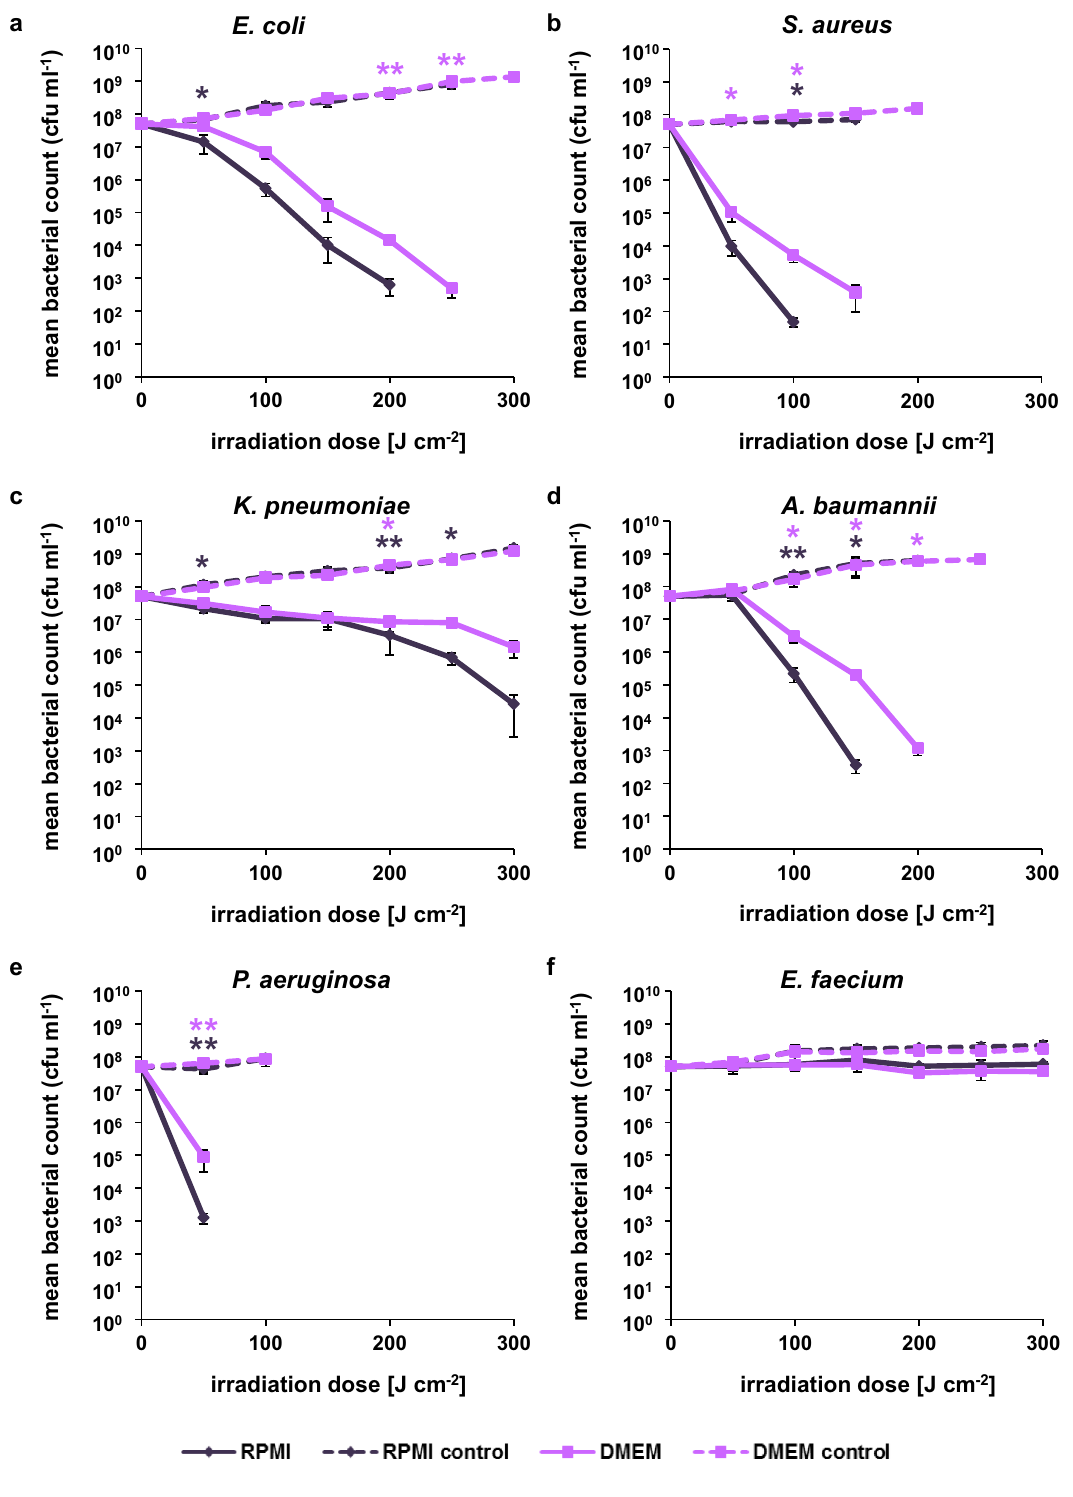
Figure 2. Survival of ESKAPE pathogens in the presence of RPMI and DMEM medium irradiated with 405 nm. ( a) E. coli . ( b ) S. aureus (ATCC43300). ( c ) K. pneumoniae . ( d ) A. baumannii . ( e ) P. aeruginosa (ATCC27853). ( f ) E. faecium . The values are expressed as log survival in comparison to starting bacterial density of 5 × 10 7 cfu ml −1 . The mean and standard deviation of three independent biological replicates with each three technical replicates are illustrated. Statistically significant differences between the irradiated samples and their respective controls are indicated with asterisks in the respective colors (* p < 0.05; ** p <